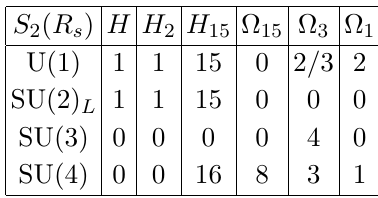
Table 3 . Dynkin representation multiplicity factor of each